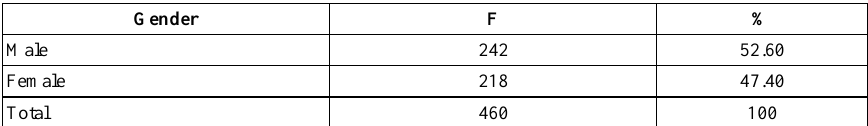
Table 1. Distribution of mechanical engineer candidates by gender Gender F % Male 242 52.60 Female 218 47.40 Total 460